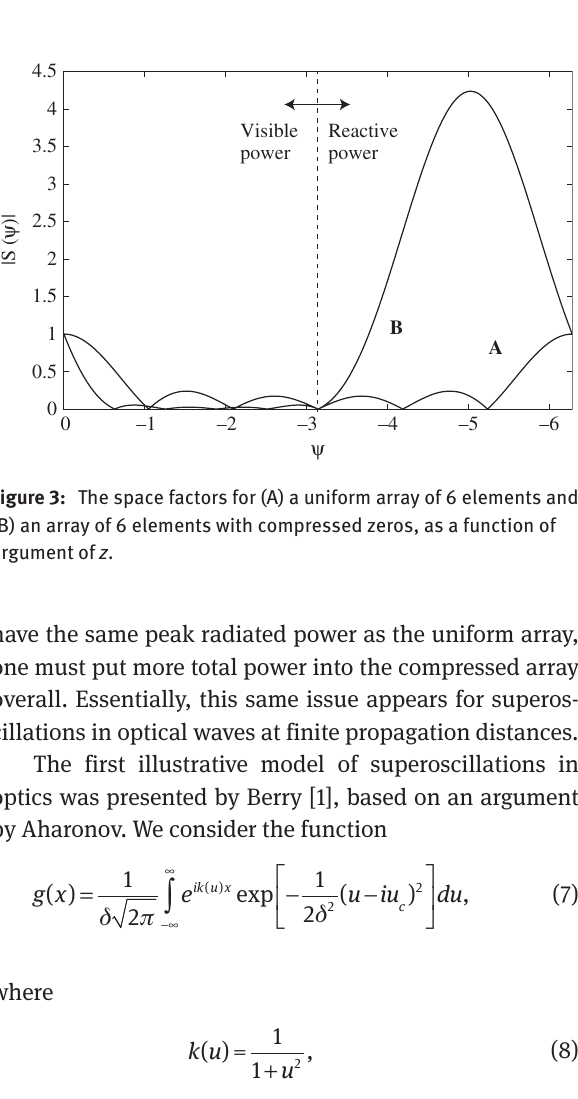
Figure 2: The space factors for (A) a uniform array of 6 elements and (B) an array of 6 elements with compressed